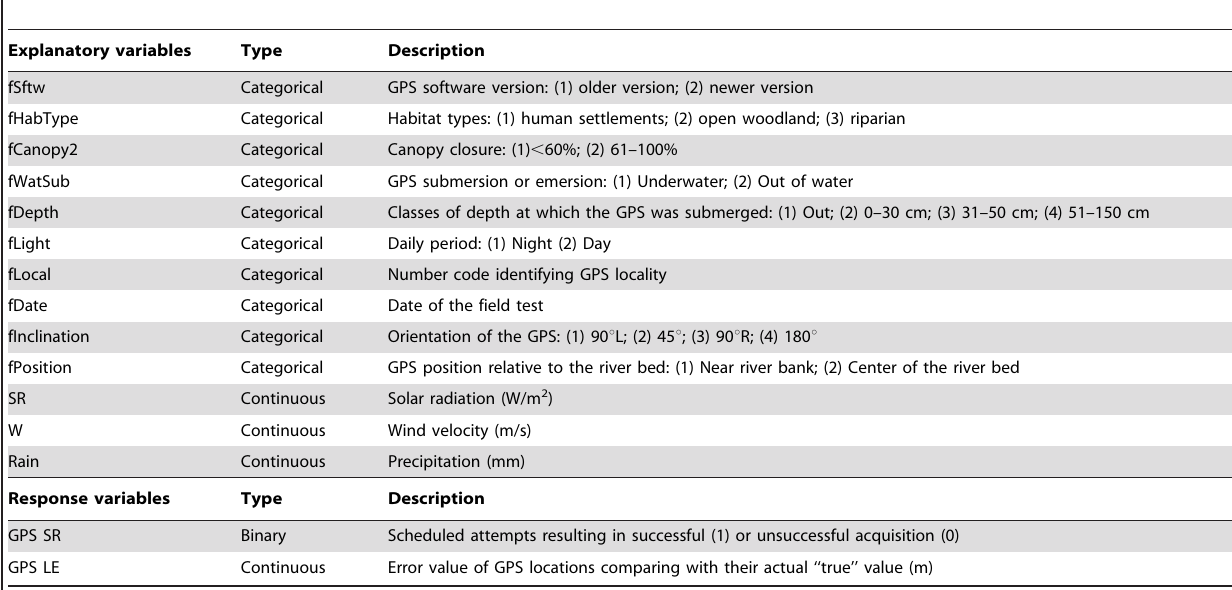
Table 1. Variables used in the evaluation of GPS performance in the stationary tests in Southern Portugal.